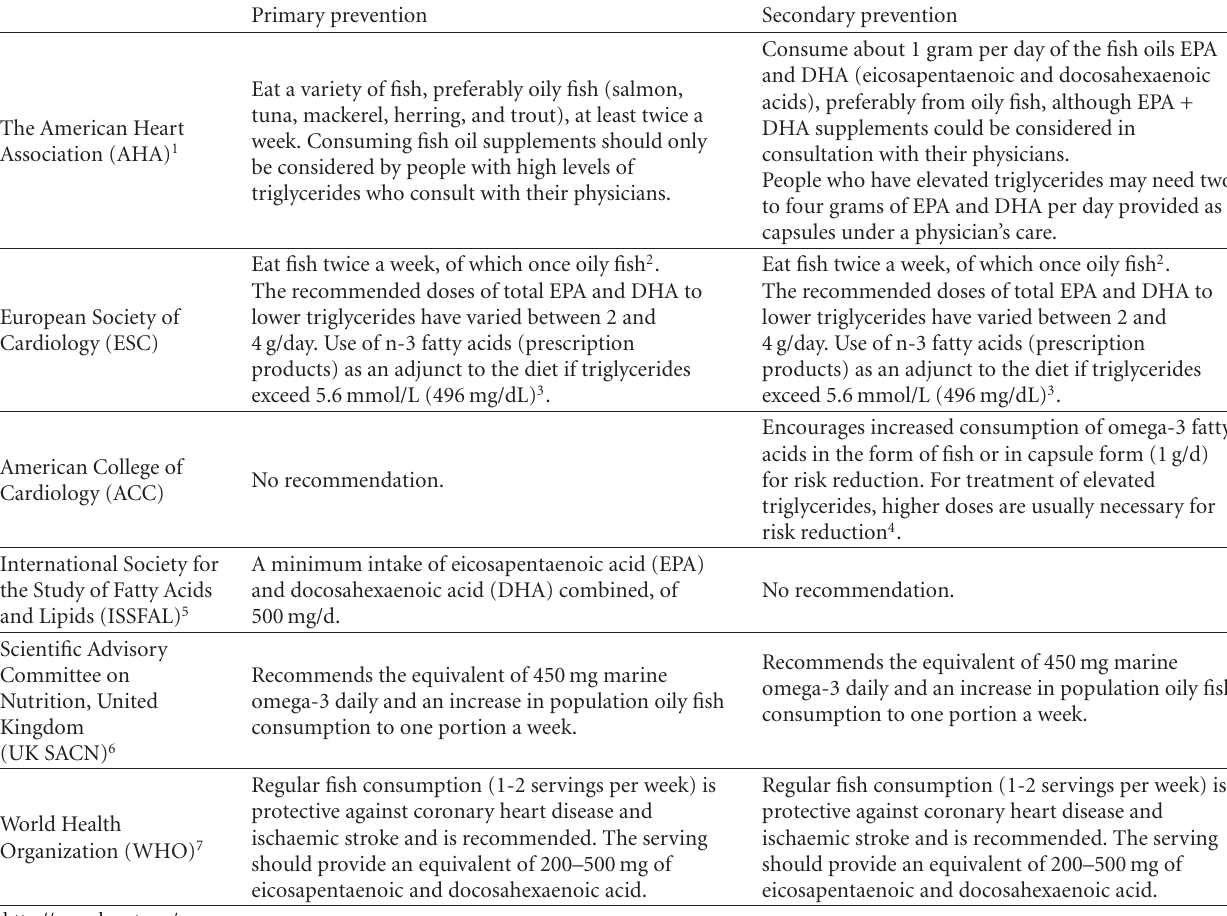
Table 3: O ffi cial recommendations for the use of marine n-3 fatty acids in CVD